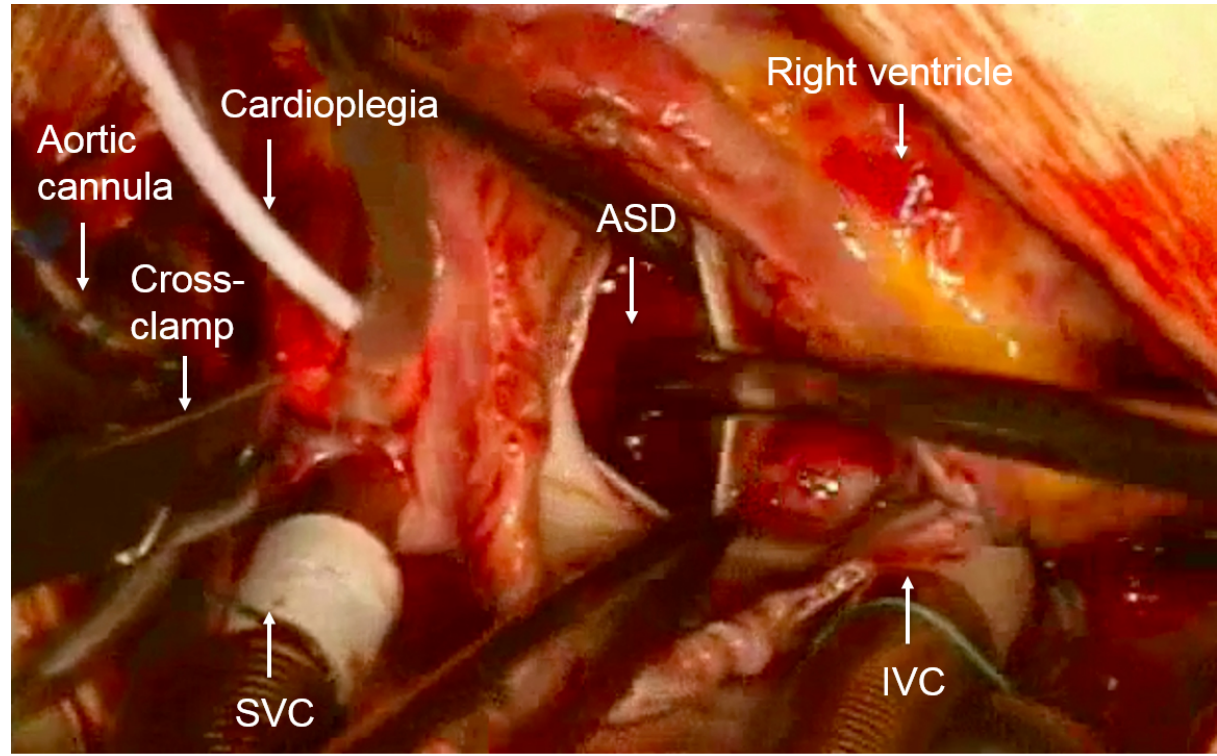
Figure 2. Image showing the heart of a child born with an atrial septal defect (ASD). The heart has been emptied of blood, put on cardiopulmonary bypass (CPB), and arrested using the cardioplegia solution, which is injected into the aortic root after the aorta is cross-clamped. CPB is achieved by inserting a superior vena cava (SVC) and an inferior vena cava (IVC) cannula for the venous drainage and an aortic cannula for the arterial perfusion of the body. The right atrium is open and the ASD is clearly